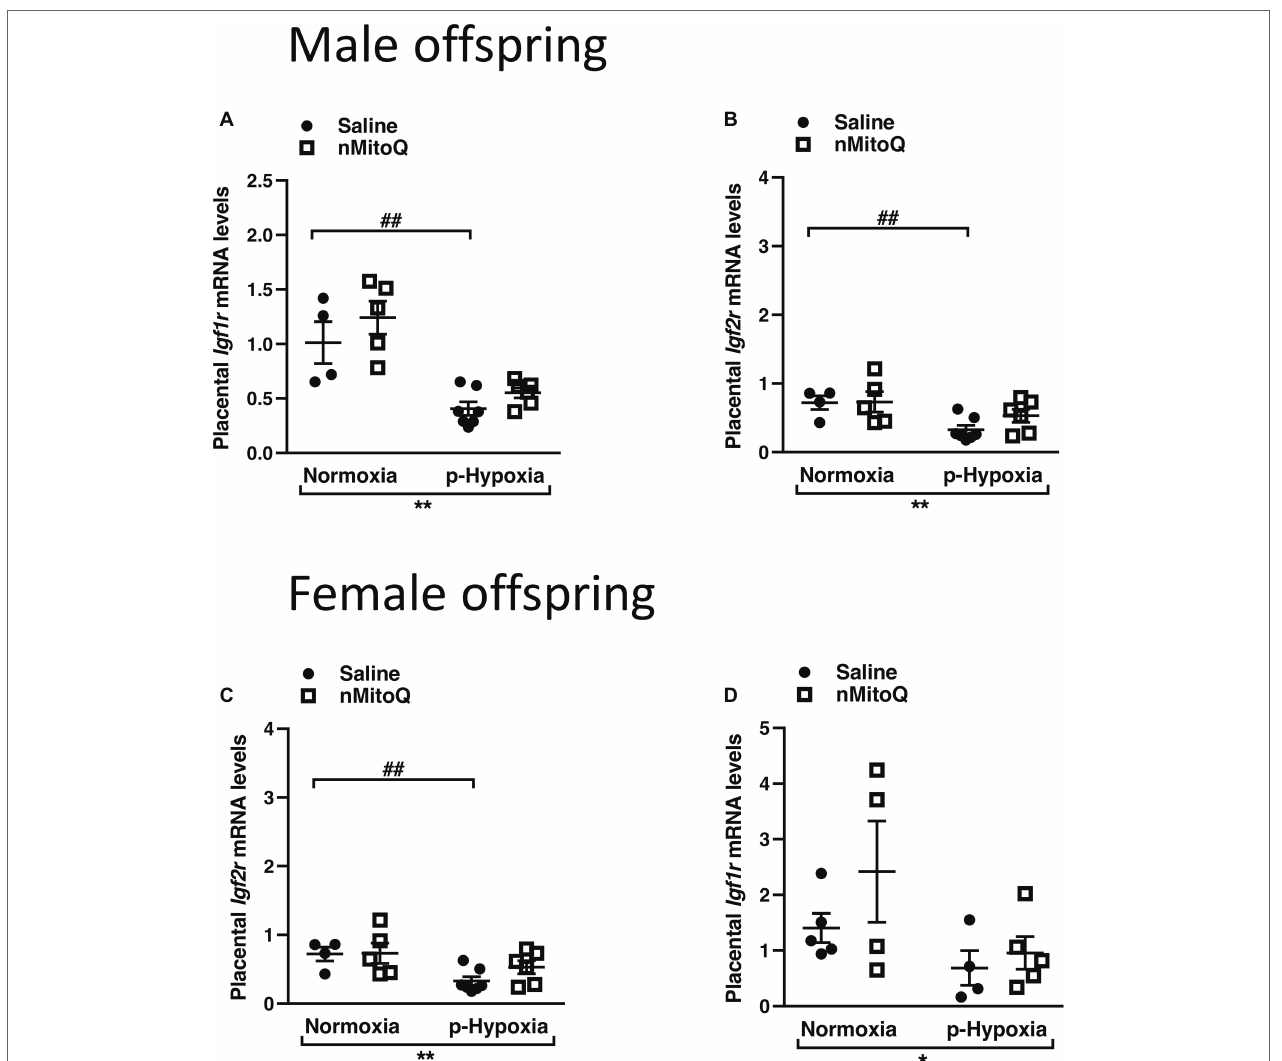
FIGURE 6 | Effects of nMitoQ treatment on Igf1r and Igf2r mRNA expression in prenatally hypoxic placentae of both male and female offspring. Receptors for IGF2, Igf1r (A,C) and Igf2r (B,D) mRNA levels were assessed by qPCR in the labyrinth zones of placentae taken from male (A,B) and female (C,D) fetuses on GD21. Data are represented as mean ± SEM. All groups were compared using a two-way ANOVA followed by Sidak’s post hoc test ( n = 4/group). * p < 0.05, ** p < 0.01 group effect of prenatal hypoxia or nMitoQ treatment; ## p < 0.01 compared to